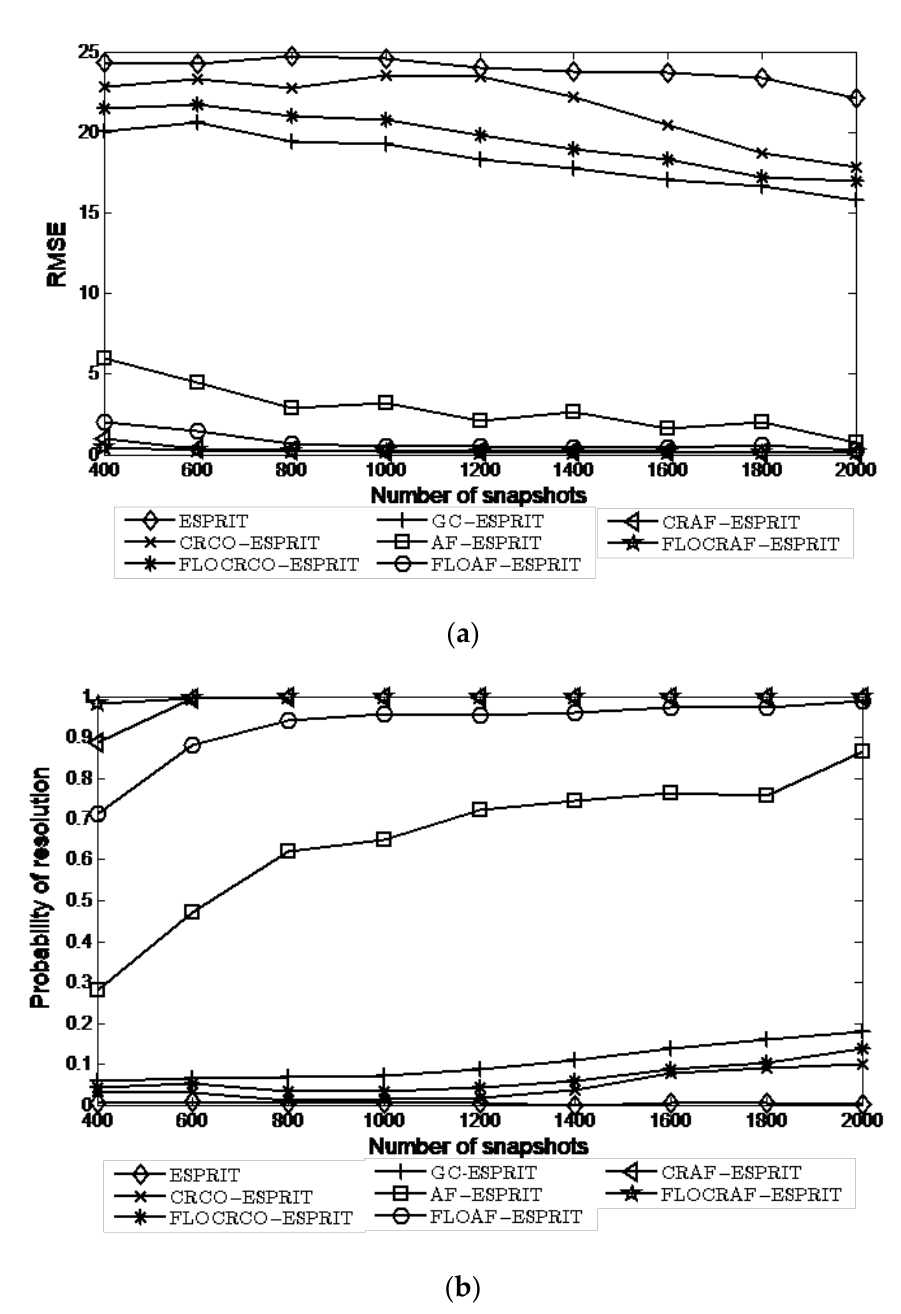
Figure 6. Performance vs number of snapshots: ( a ) RMSE; ( b ) Probability of resolution.